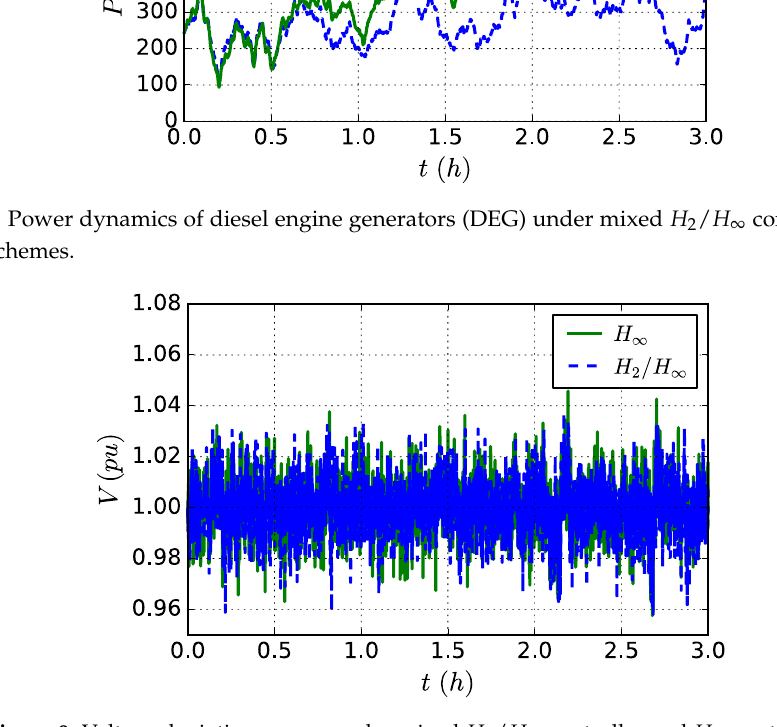
Figure 9. Voltage deviation curves under mixed H 2 / H ∞ controller and H ∞ controller.